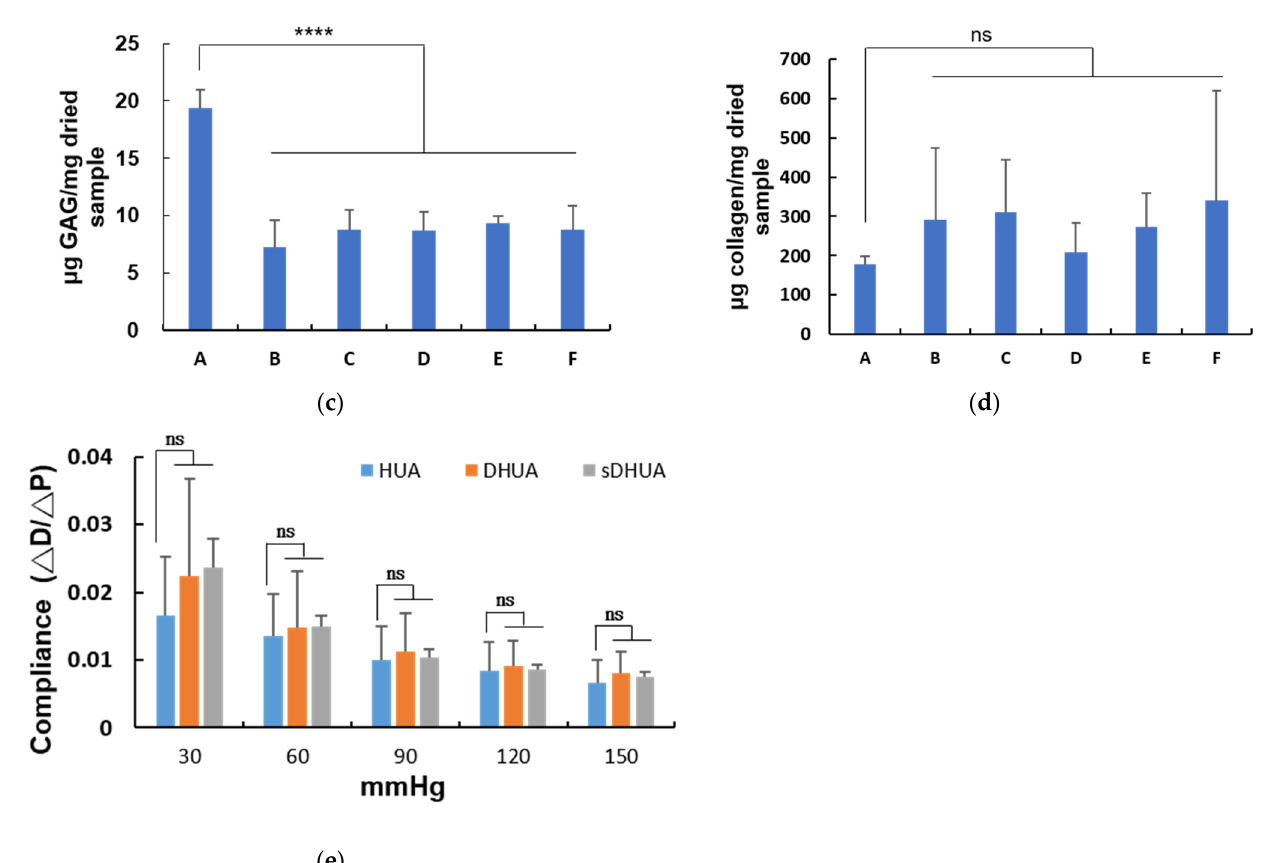
Figure 3. ( a) –( e ): DNA, elastin, GAGs, and collagen content of sDHUA compared with HUA and cDHUA. (A:HUA, B:cDHUA, C:sDHUA, 204 W for 4 h, D:sDHUA, 204 W for 8 h, E:sDHUA, 285 W for 2 h, F:sDHUA, 285 W for 4 h). ( a ) DNA content (n = 3); ( b ) elastin content (n = 4); ( c ) GAG content (n = 4); ( d ) collagen content (n = 4). ( e ) Mechanical property (compliance) between HUA, cDHUA, and sDHUA at different pressure. ( λ = 1.3). *: p < 0.05, **: p < 0.01, ***: p < 0.005, ****: p < 0.001, ns: no significance.